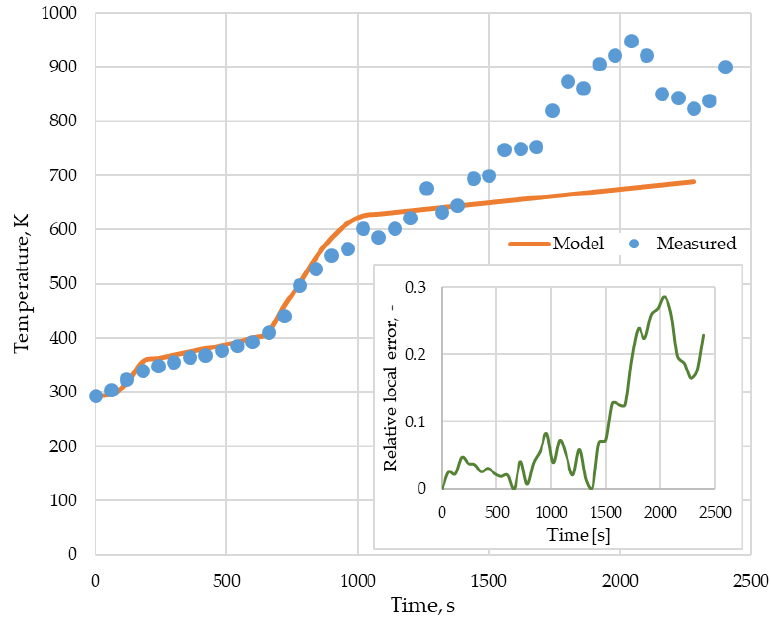
Figure 18. Comparison of the temperature distribution measured with the temperature calculated from the model.